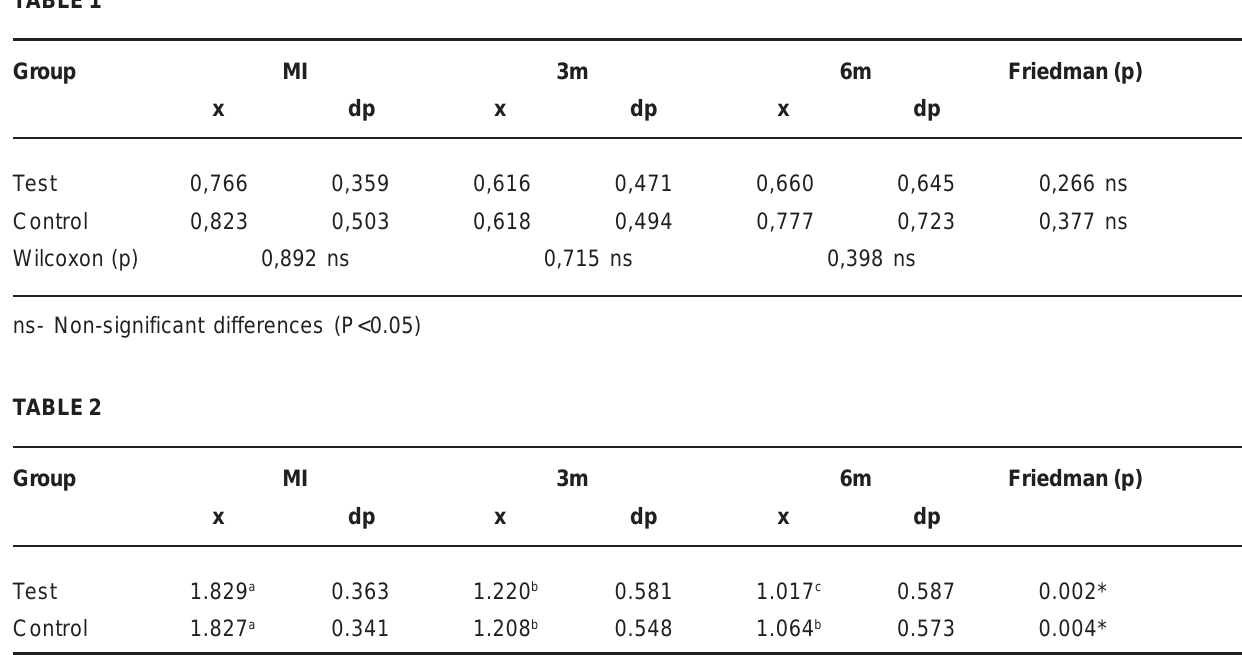
* statistically significant difference (P<0.05) Same letters indicate non-significant differences